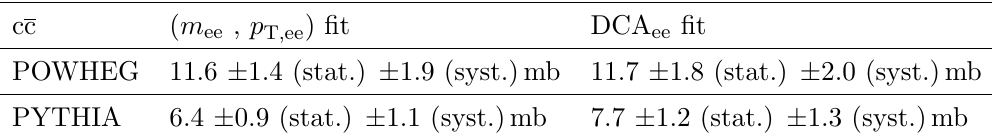
Table 4 . Summary of the total cc cross sections extracted from a (cid:12)t of the measured dielectron spec- tra from heavy-(cid:13)avour hadron decays in ( m ee , p T ; ee ) and in DCA ee with PYTHIA and POWHEG. The uncertainty of 22% on the branching fractions and fragmentation functions (BR c ! e ) is not listed.